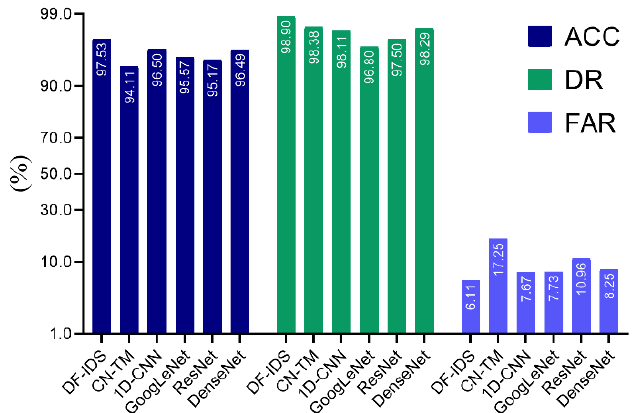
Figure 10. Comparison of binary classifications with smaller-scale dataset.